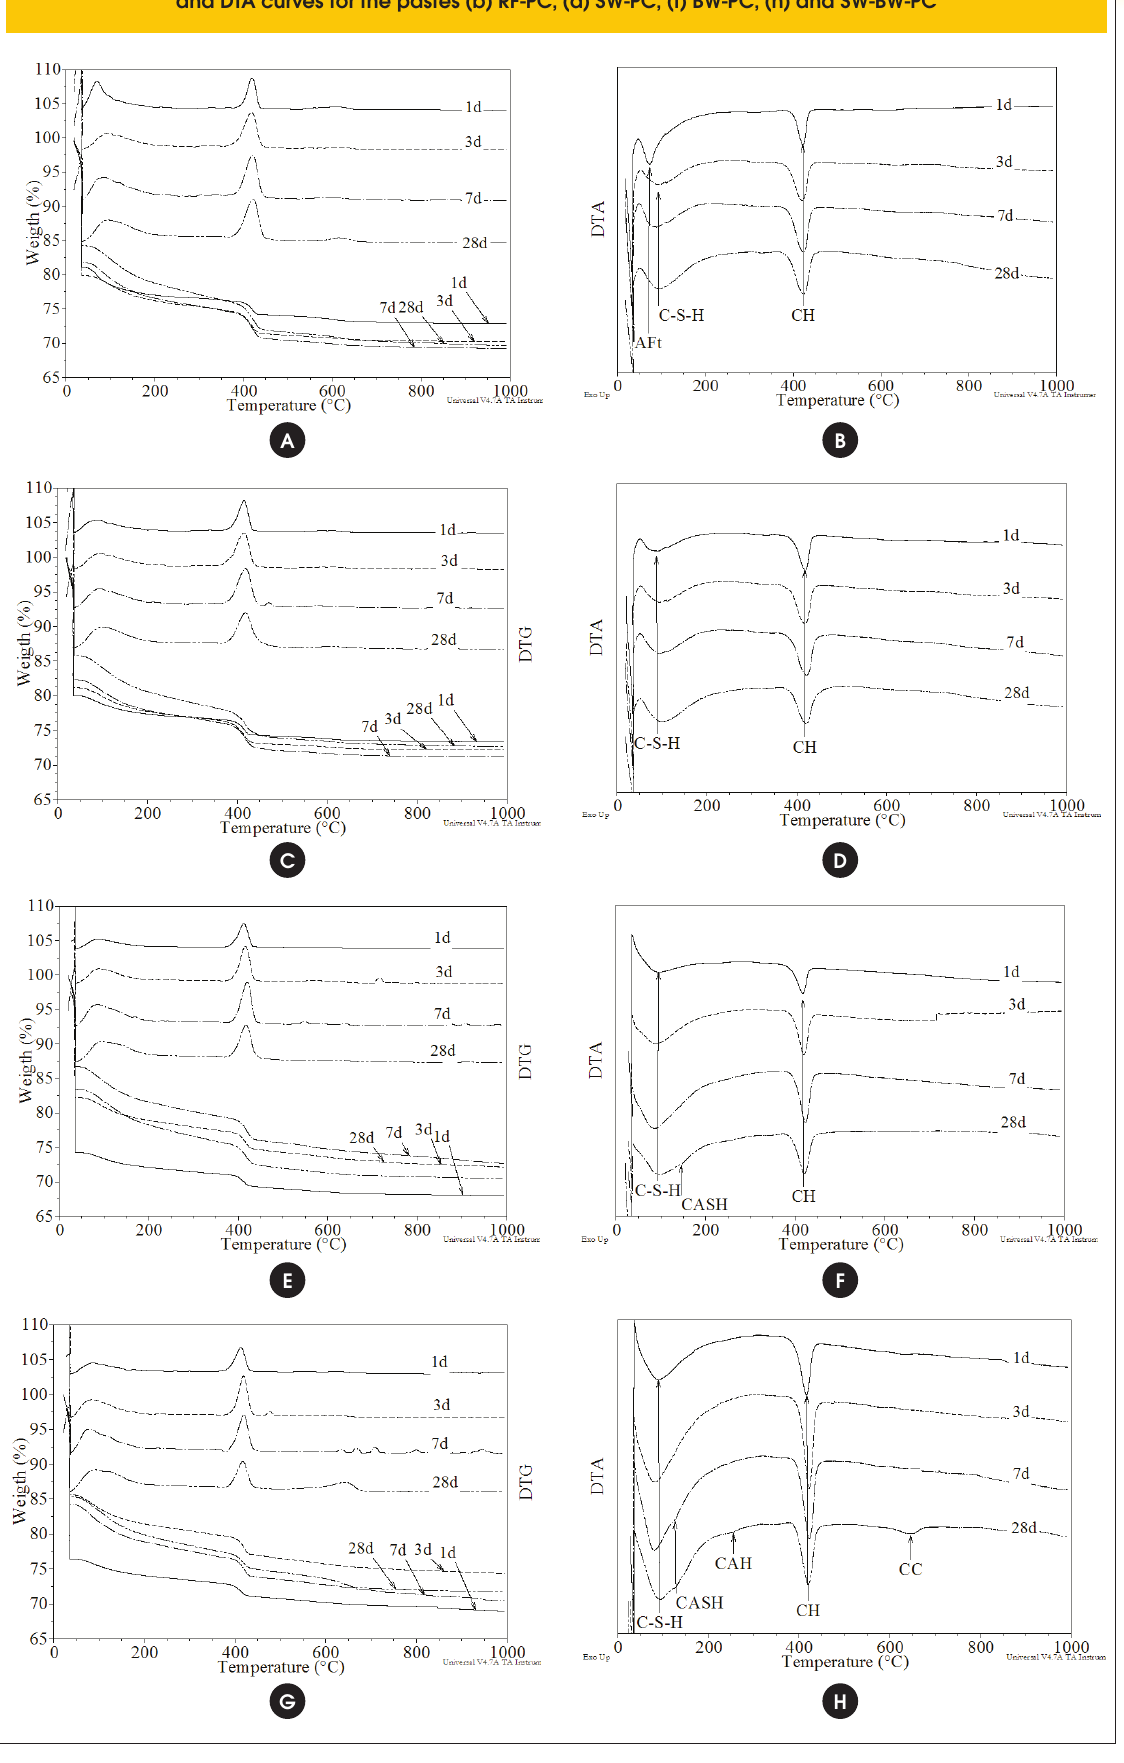
Figure 6 – TG/DTG Curves for the pastes (a) RF-PC, (c) SW-PC, (e) BW-PC, (g) SW-BW-PC; and DTA curves for the pastes (b) RF-PC, (d) SW-PC, (f) BW-PC, (h) and